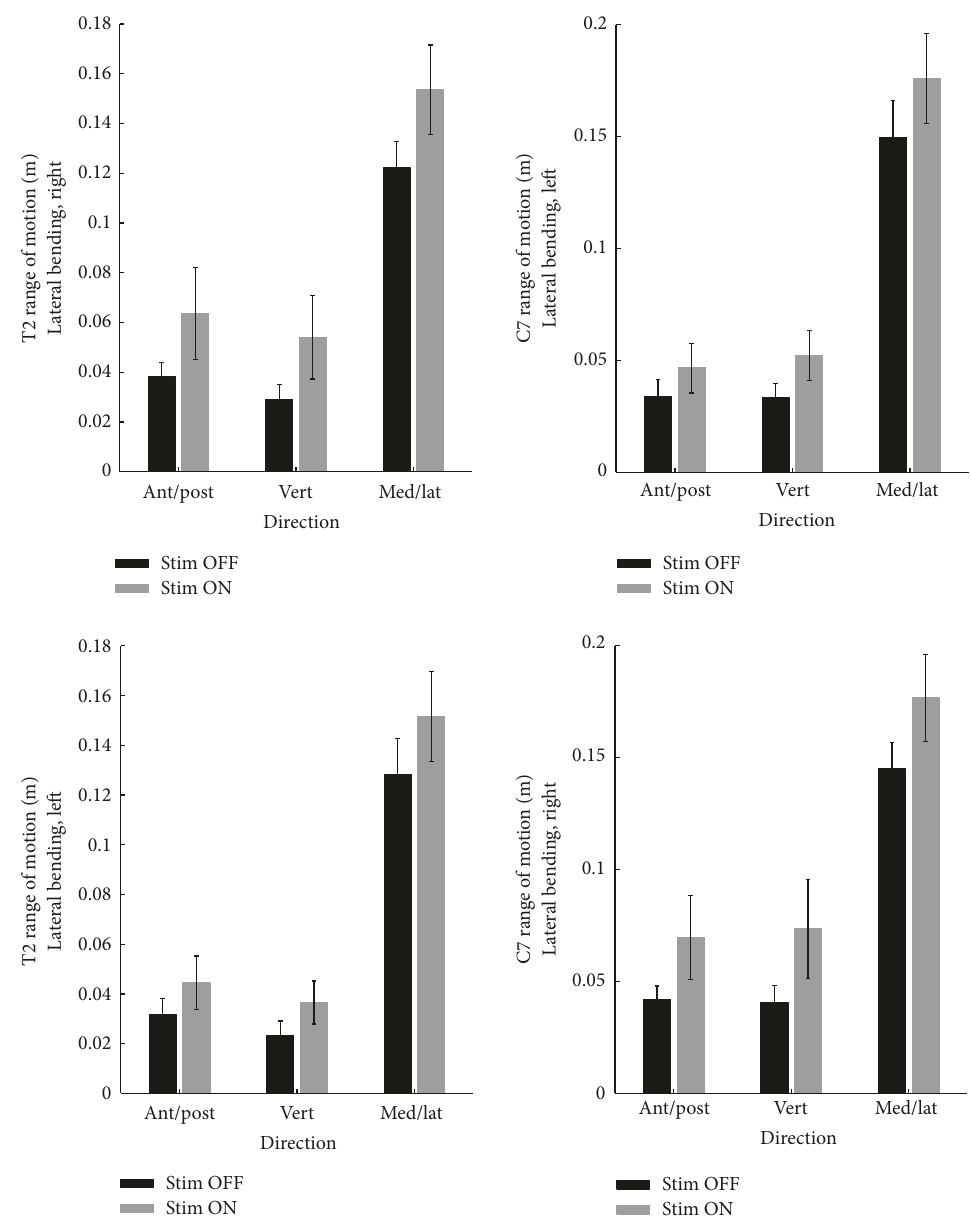
Figure 3: Improvements in cervical and dorsal spine ROM in lateral bending on both sides during